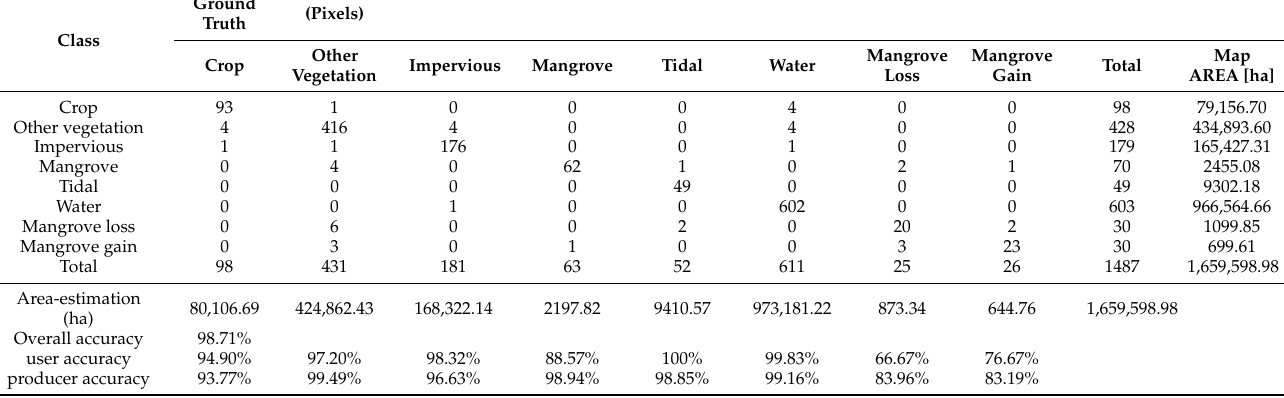
Table 3. Accuracy assessment and area mapping for stable land cover and mangrove loss and gain from 2000 to